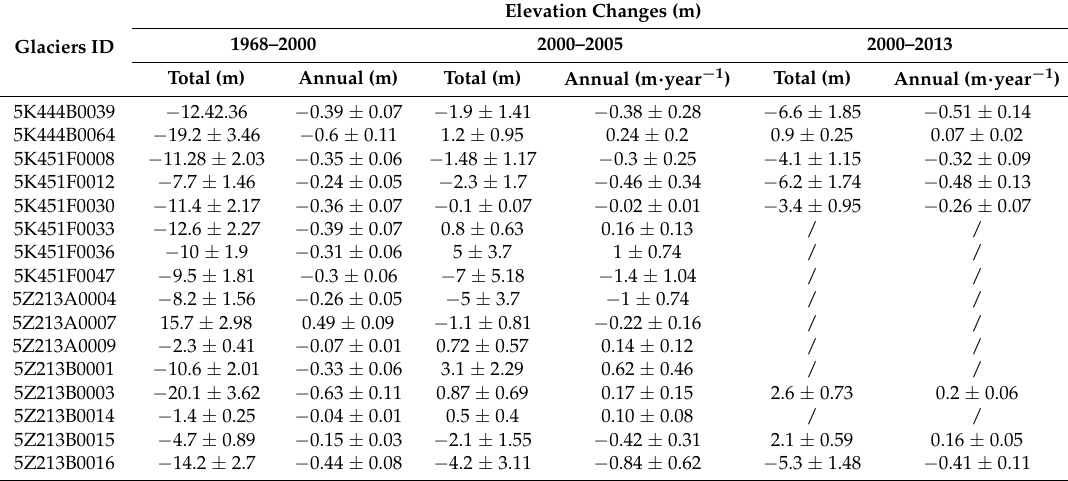
Table 5. Glacier surface elevation changes of ten advancing glaciers from 1968 to 2013.